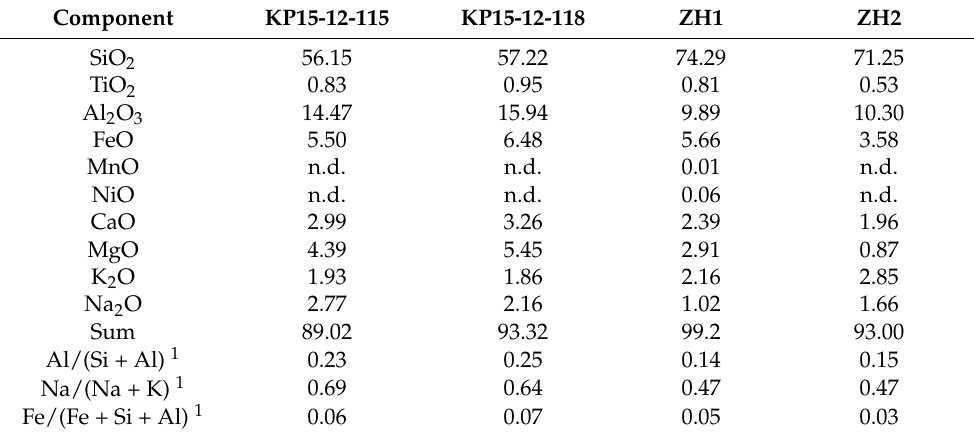
Table 1. Major element contents of the UHPHT and LP impact glasses, average microprobe data,